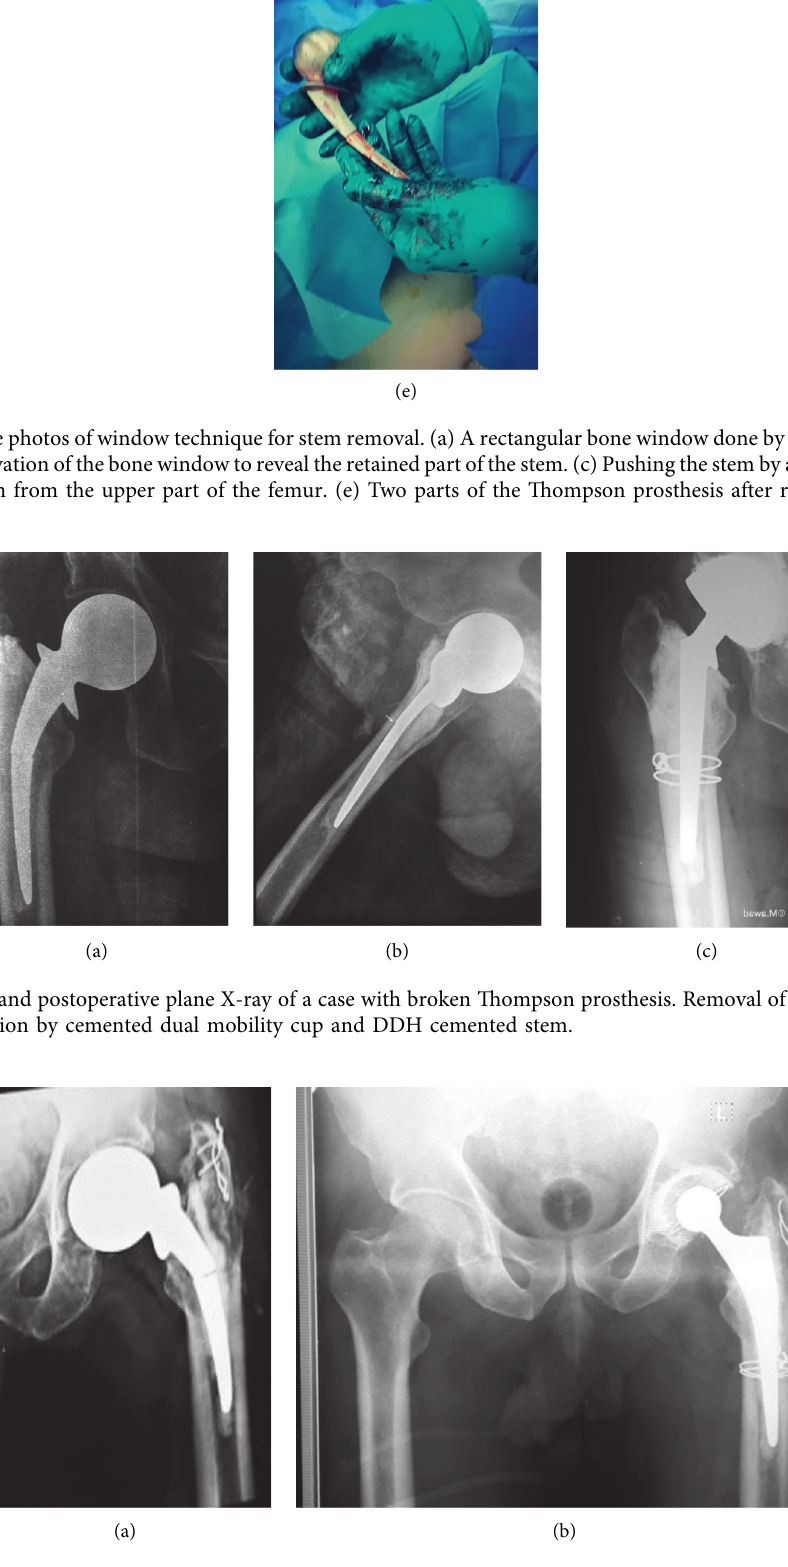
Figure 4: Preoperative and postoperative plane X-ray of a case with broken Thompson prosthesis. Removal of the broken stem by lateral bone window and revision by cemented polyethylene cup and cemented